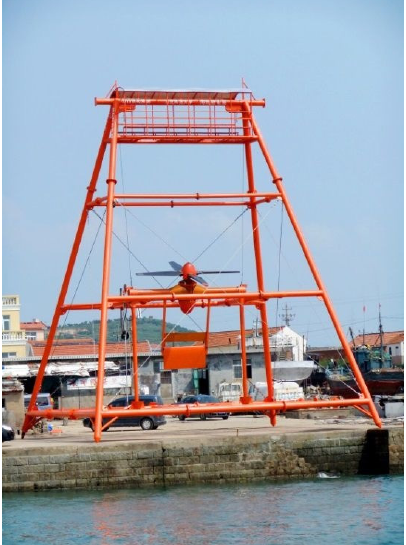
Figure 13. A 20 kW gravity-based tower-type horizontal-axis TCPGS. Reproduced from [33]. In 2013, NENU and HangZhou JiangHe Hydro-Electric Science & Technology Co., Ltd.